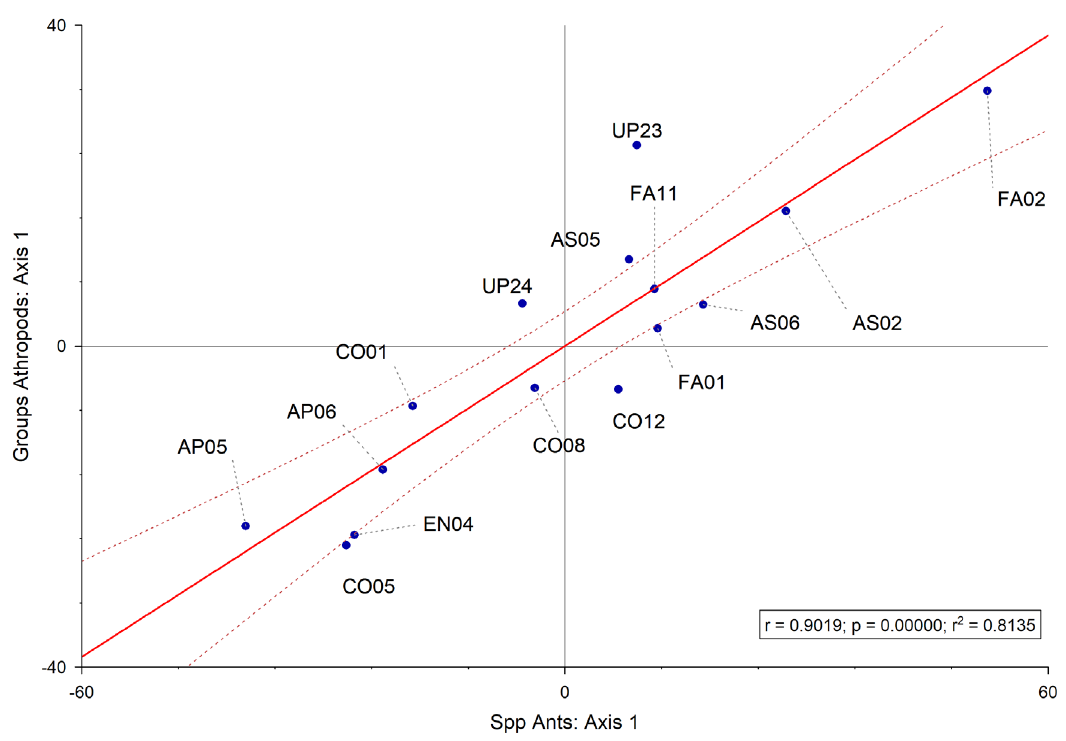
Fig 3 . Correlation PLS of scores for axis 1 for the block of arthropod groups versus